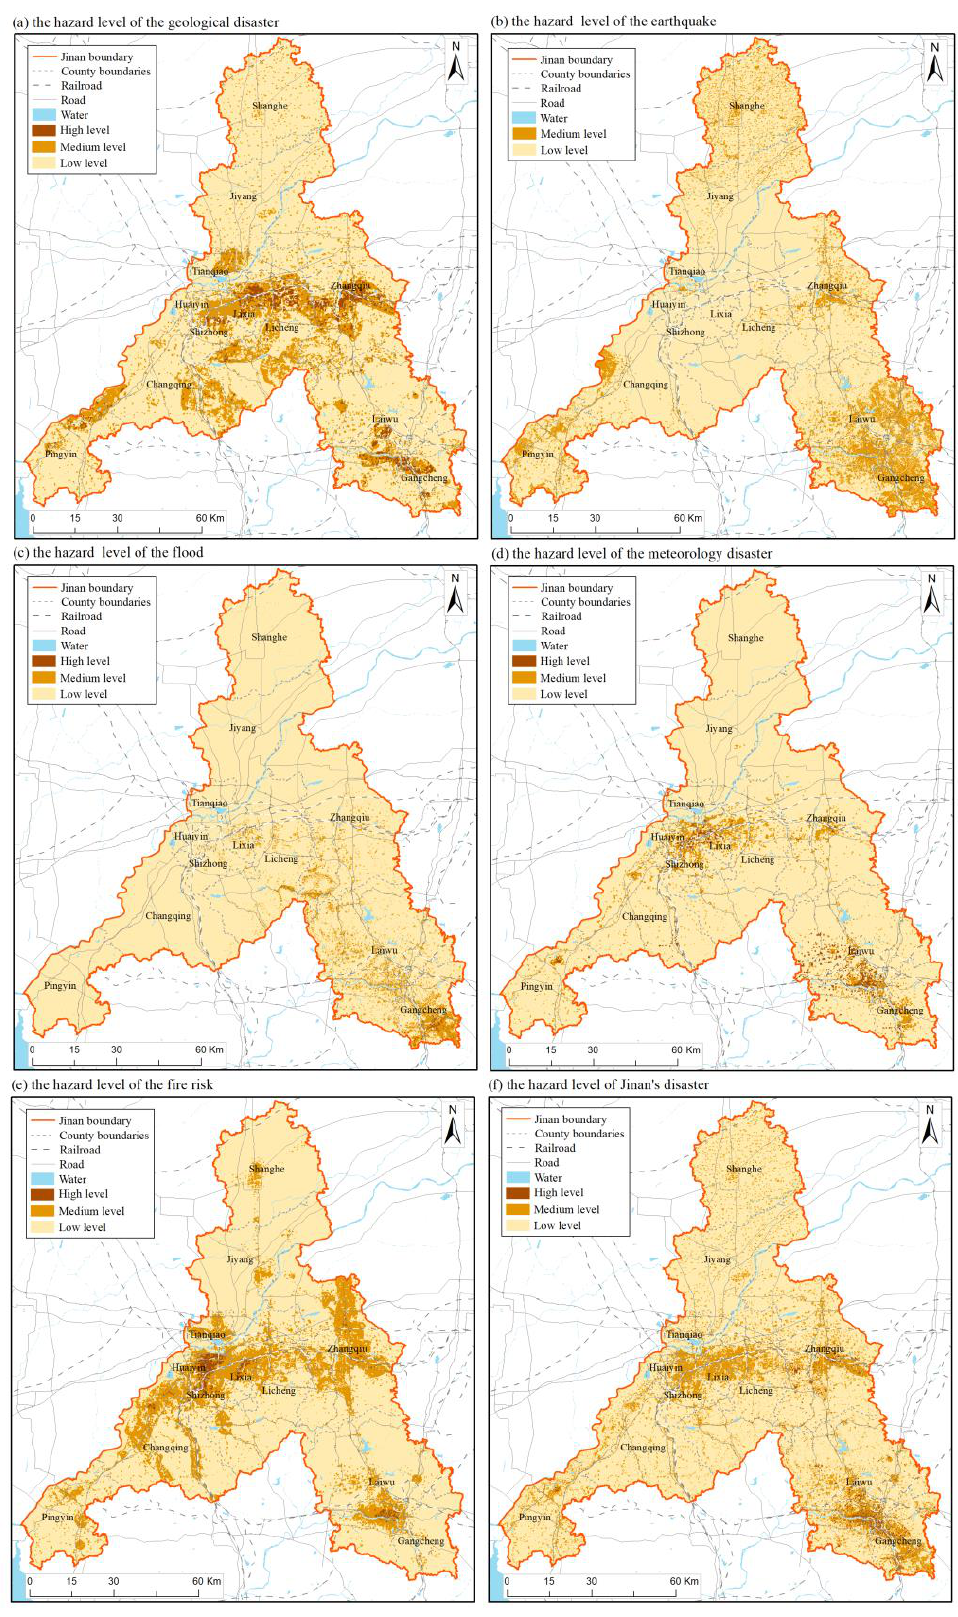
Figure 3. Result map of hazard assessment.